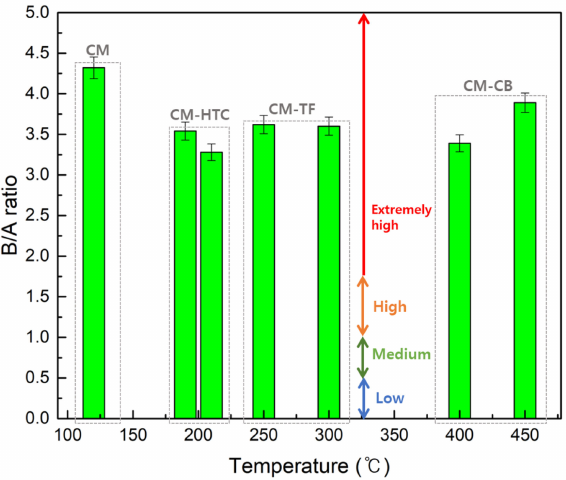
Figure 7. B/A ratio in the cattle manure, hydrochar, torrefied char, and